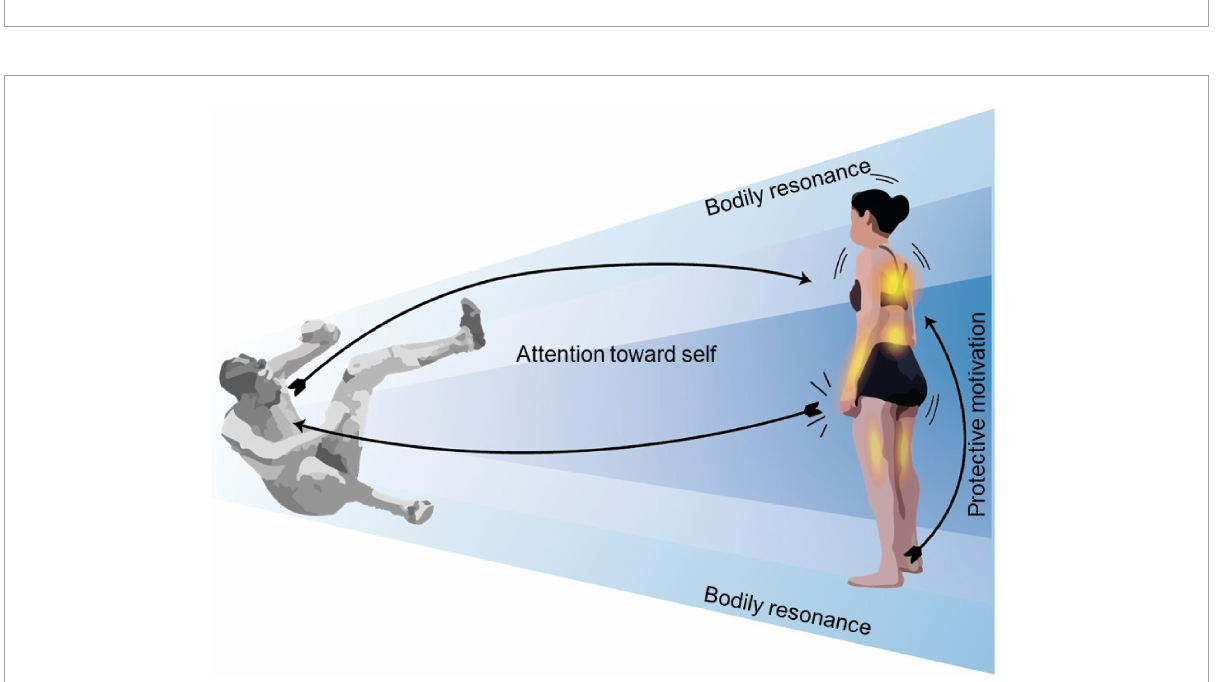
FIGURE3 Experiential structure of self-centered empathy for pain. The empathizer’s intentional object is the empathized experience; they see the sportsperson as sentient and having a painful experience. This empathic structure is characterized by bodily resonance, attentional focus centered on the participant’s own experience of seeing the other suffer, and self-protective kinesthetic